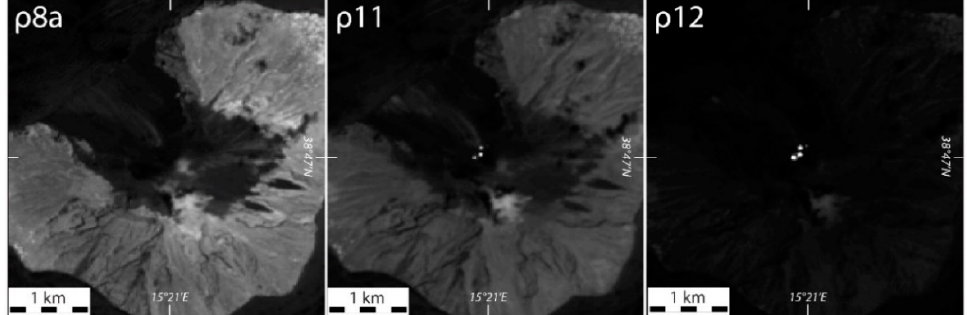
Figure 2. SENTINEL-2 images of ρ 8a (865 nm), ρ 11 (1610 nm) and ρ 12 (2190 nm) bands in grayscale colors, over Stromboli summit volcano, 12/07/2018. The three separated thermal anomalies, particularly evident in the 11 and 12 bands, are related to the three main summit craters of Stromboli.